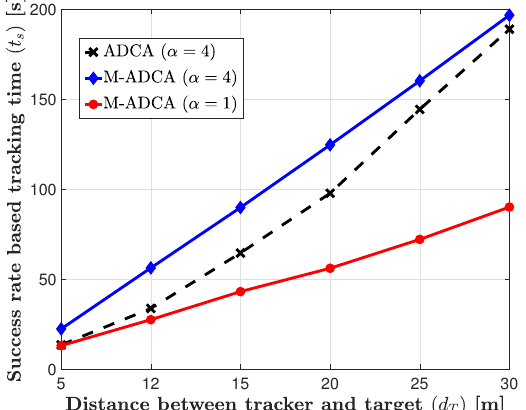
Figure 6. Performance Comparison of ADCA and M-ADCA (ADCA with